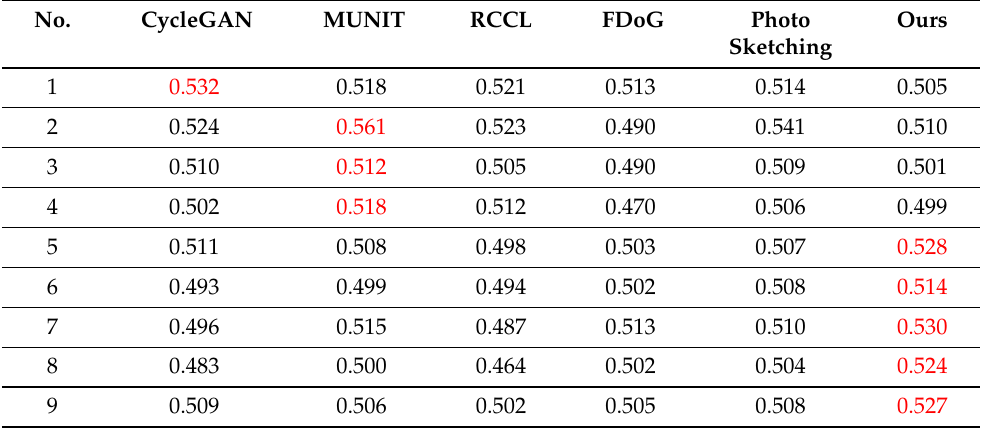
Table 2. The recalls estimated on the sketches in Figure 7. The red figures denote maximum recall in each